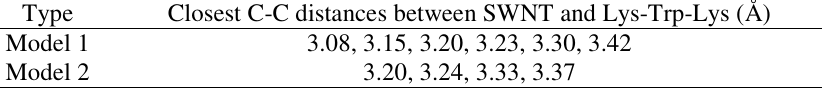
Figure 2. DFT-level optimised structures of two different models of composites. Table 2 . Closest C-C distances between SWNT and